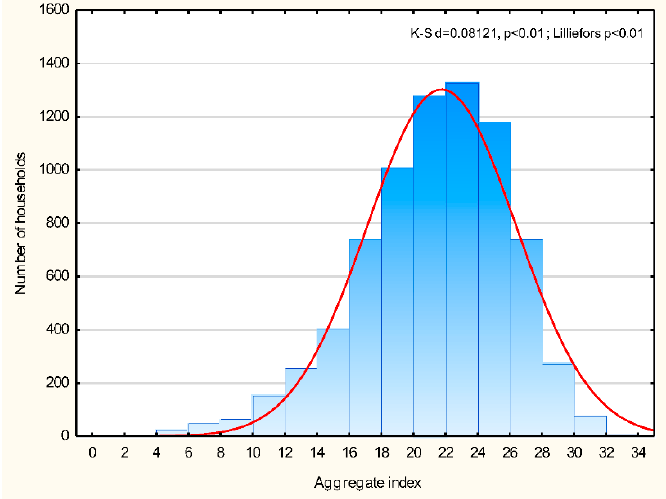
Figure 6. Distribution of the aggregate indicator for one-person households in 2016. Source: own calculations based on CSO data.